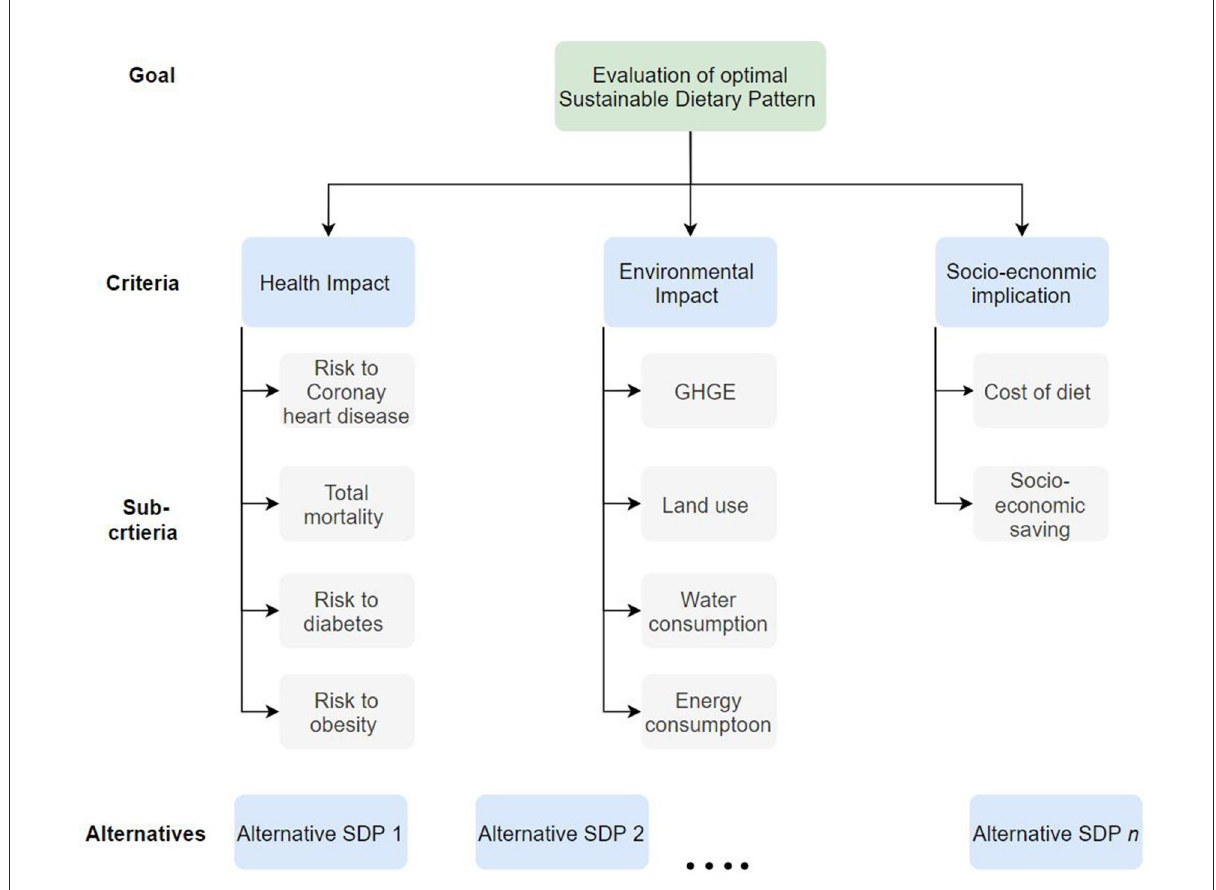
FIGURE2 Hierarchical breakdown for assessing the performance of diet